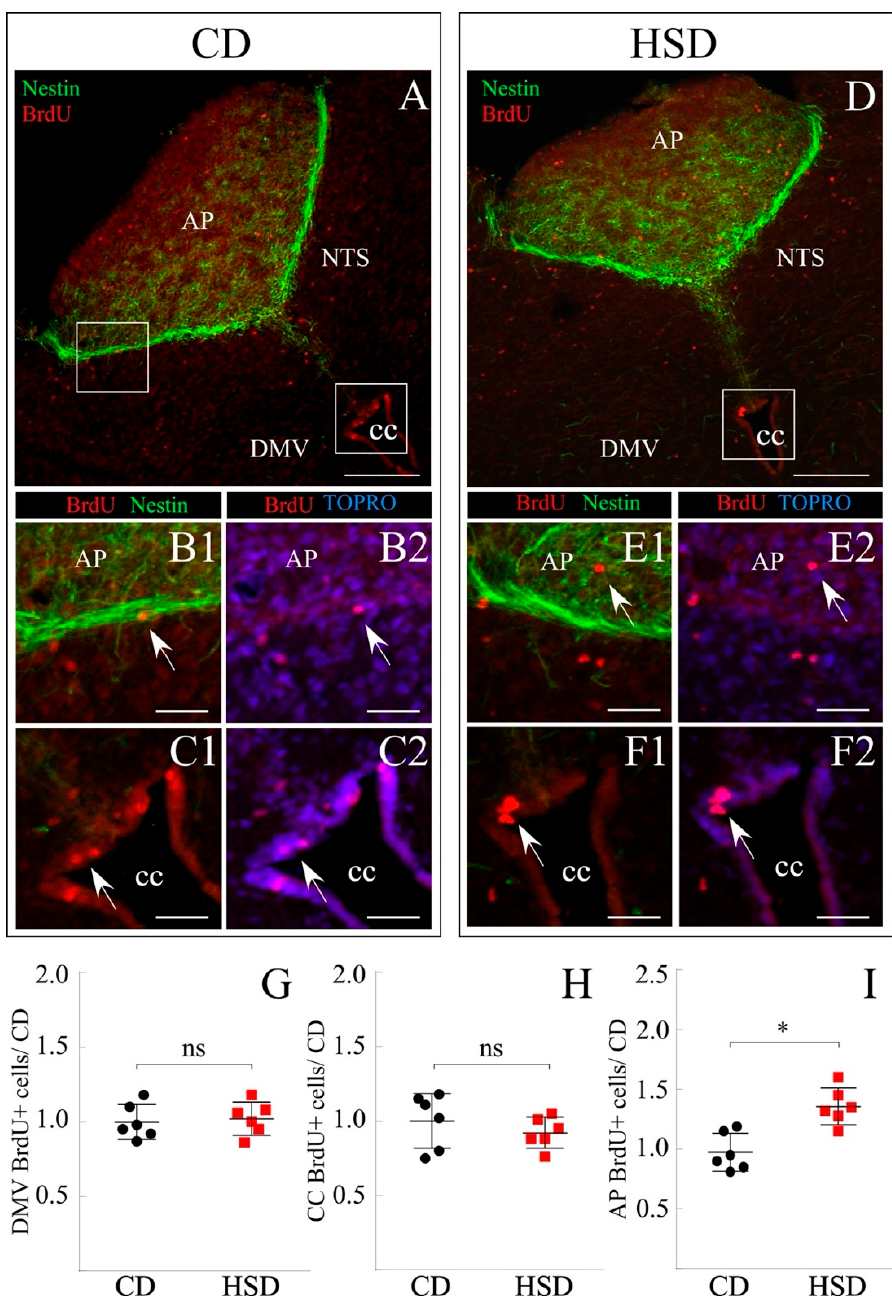
characteristics were found in DMV (Figure 5A,D), AP, and NTS (Figure 5B,E), as well as at the dorsal roof of the CC (Figure 5C,F) for the CD and HSD, respectively.